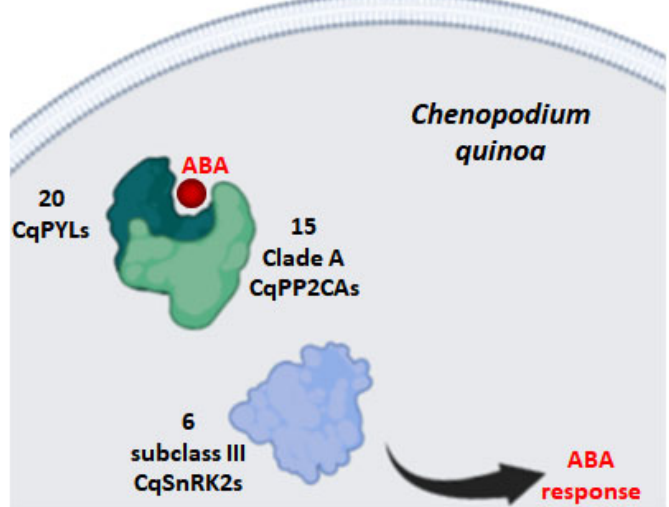
Figure 1. ABA perception and signaling in quinoa. ABA is perceived by the CqPYL receptors (20 in quinoa [60]). A ternary complex should be formed upon ABA perception between the phytohormone, CqPYLs, and CqPP2Cs (there could be approximately 15 ABA-related clade A PP2Cs as a rough estimation from annotations in quinoa genome.Finally, released subclass III CqSnRK2s must trigger ABA response (6 genes reported in [68]). Icons were obtained from Biorender.